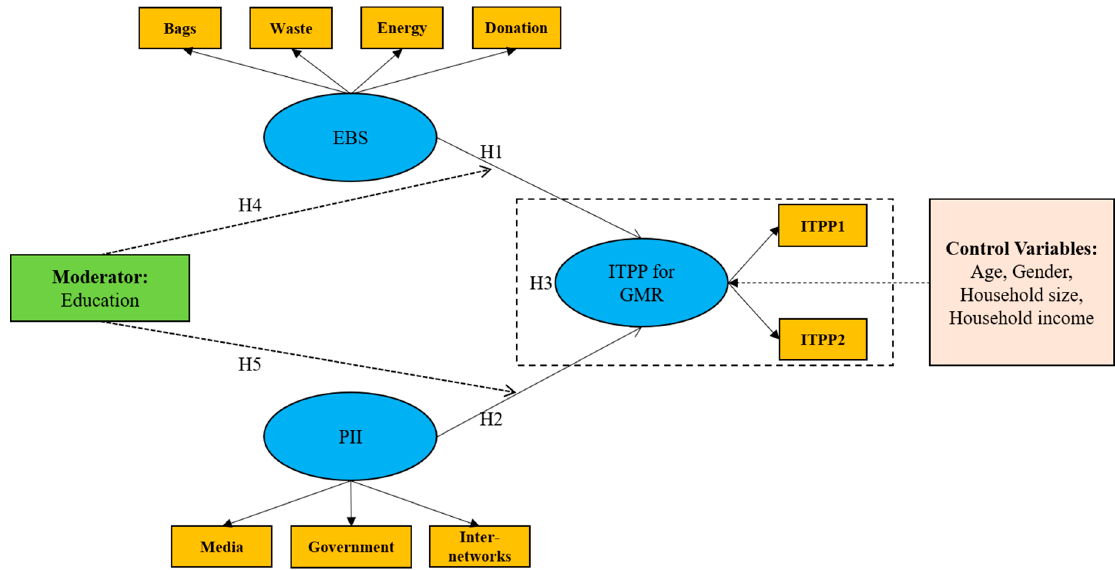
Figure 2. The theoretical framework for determinants of consumers’ ITPP for